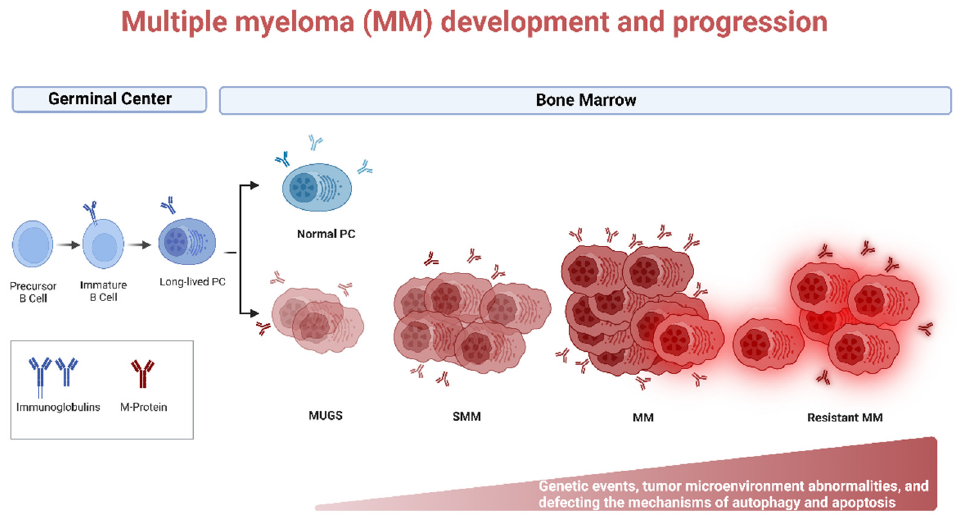
Figure 1. Biology of Multiple myeloma (MM) development and progression. MM is the end stage of a multistep neoplastic transformation of PCs. MGUS and SMM are the precursor stages of MM. Increase in aberrant PCs, Igs, and cytogenetic and tumor microenvironment abnormalities precede the onset of symptoms of MM. Relapsed/refractory (R/R) patients often present with a more aggressive phenotype. Genetic events, tumor microenvironment abnormalities, and defective autophagy and apoptosis may occur during MM progression. Created using Biorender.com (accessed on 1 November 2022). Table 1. Mechanism of action and underlying drug resistance mechanisms of the common chemother- apeutic